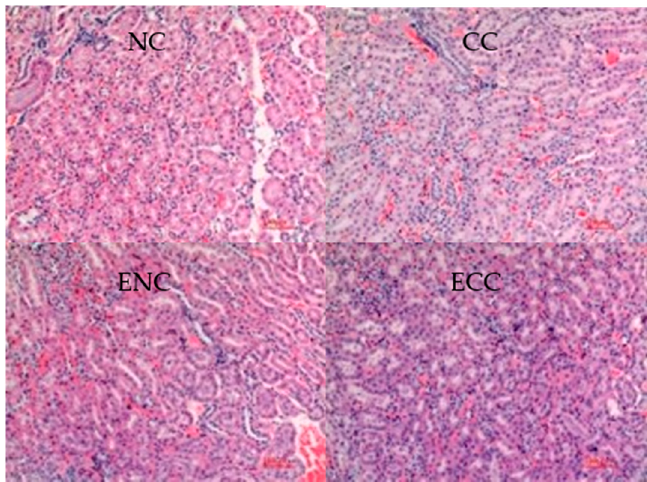
Figure 3. Kidney histopathological tissue sections of ICR mice.